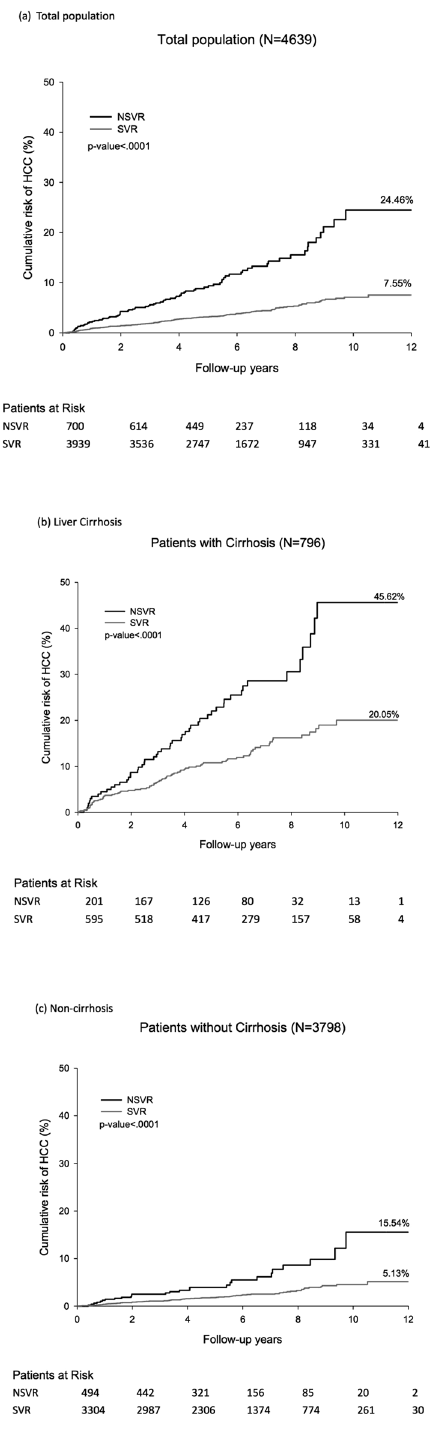
Figure 1. Cumulative risk of HCC after long-term follow-up. ( a )Total participants. ( b )Patients with liver cirrhosis at study entry. ( c )Patients without liver cirrhosis at study